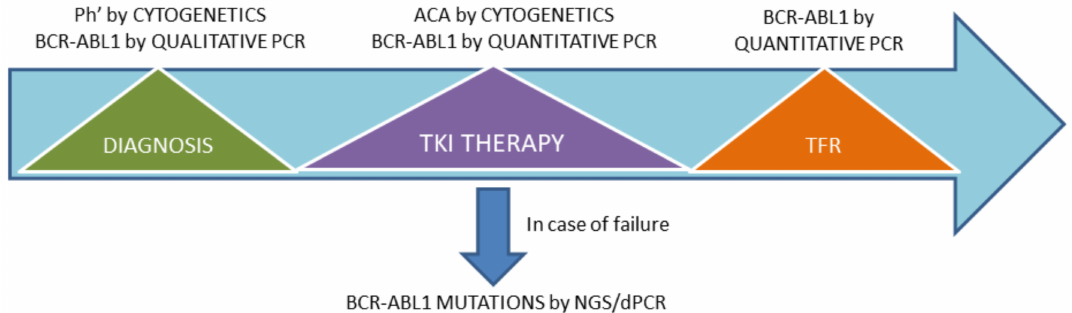
Figure 1. Flow chart of “biological” routine assessments to be performed in chronic myeloid leukemia (CML) patients according to the 2020 European Leukemia Net (ELN) recommendations. At diagnosis, it is mandatory to perform cytogenetics (chromosome banding analysis) to detect the Philadelphia (Ph1) chromosome and qualitative PCR to identify the BCR-ABL1 fusion transcript type. During treatment, after the achievement of a complete cytogenetic response (no metaphases positive for the Ph1 chromosome out of a minimum of 20 metaphases examined), cytogenetic tests are advised only in cases with additional chromosomal aberrations (ACA) in the Philadelphia-positive clone, whereas quantitative PCR for BCR-ABL1 has to be performed on a regular basis to monitor transcript levels (minimal residual disease (MRD)). Lastly, in treatment-free-remission (TFR), only quantitative PCR for BCR-ABL1 transcript is needed. In cases of an unsatisfactory response, it is recommended to search for BCR-ABL1 mutations by Sanger sequencing or next-generation sequencing